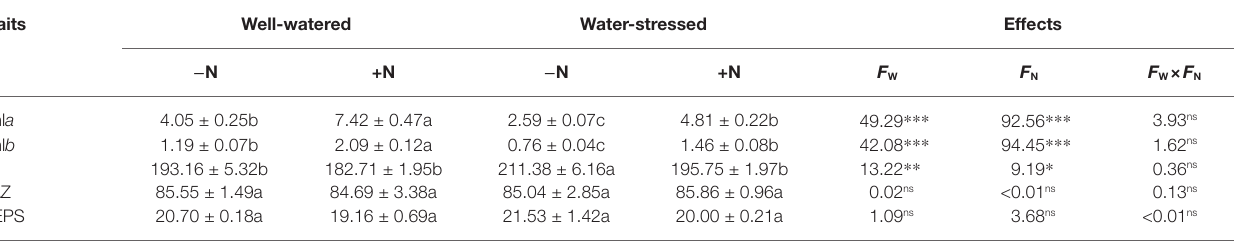
TABLE 2 | Pigments content of Fargesia denudata leaves for N non-deposition ( − N) and N deposition (+N) treatments with and without drought stress. Traits